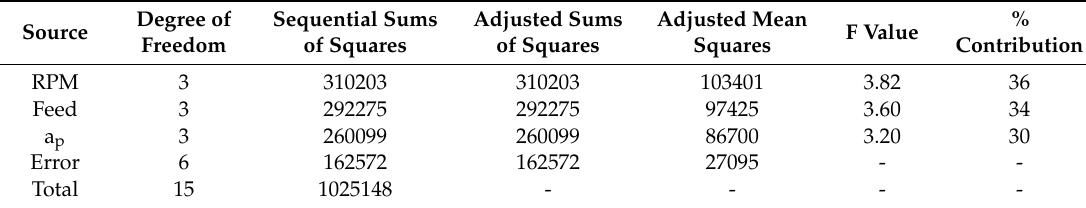
Table 6. Analysis of variance for cutting force (FC).